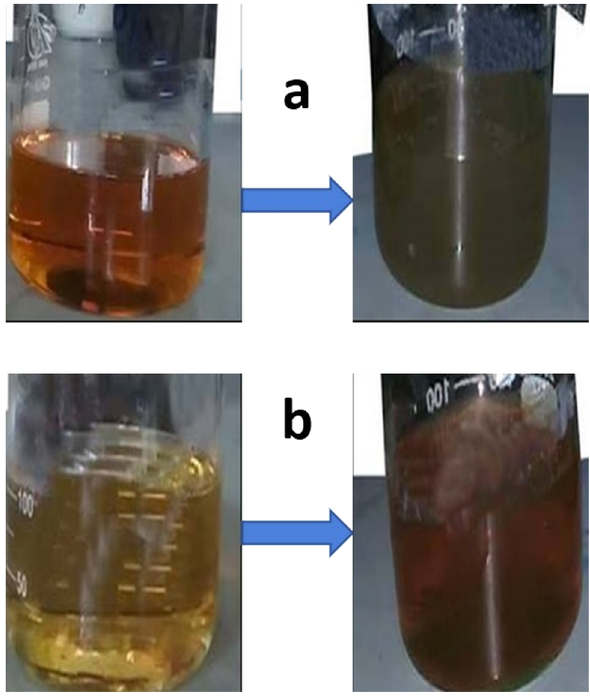
Figure 2: Visual observation of formation of Ag - NPs in the colloidal solution of plant extract and AgNO 3 : ( a ) from leaf and ( b ) from